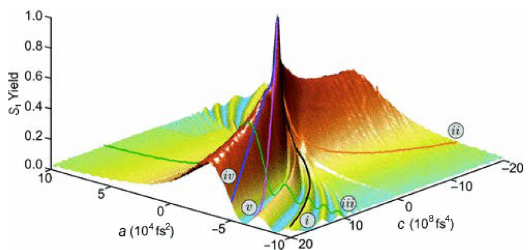
Fig. 7 Experimental sampling of constrained quantum control landscapes of the second harmonic generation. Reproduced with permission from Ref. [64], (cid:13) C 2009